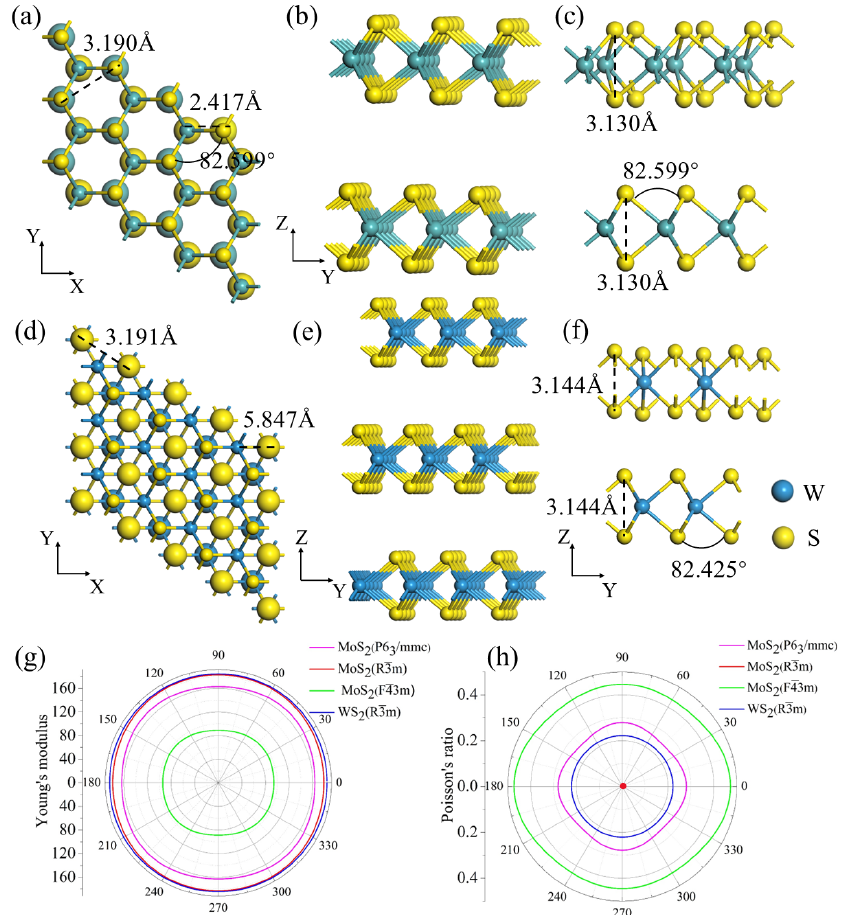
Figure 2. ( a ) Structural snapshots (top view) of MoS 2 (space group P6 3 /mmc). ( b ) Side view of MoS 2 (space group P6 3 /mmc). ( c ) Local enlargement of a side view of the monolayer MoS 2 (space group P6 3 /mmc). ( d ) Structural snapshots (top view) of WS 2 (space group R3m). ( e ) Side view of WS 2 (space group R3m). ( f ) Local enlargement of the side view of the monolayer WS 2 (space group R3m). ( g ) Summary graph of Young’s modulus and ( h ) PR of four materials. To show their structure more clearly, the above materials are enlarged for the part of the atoms that are obscured between the layers; this does not mean that they are different in